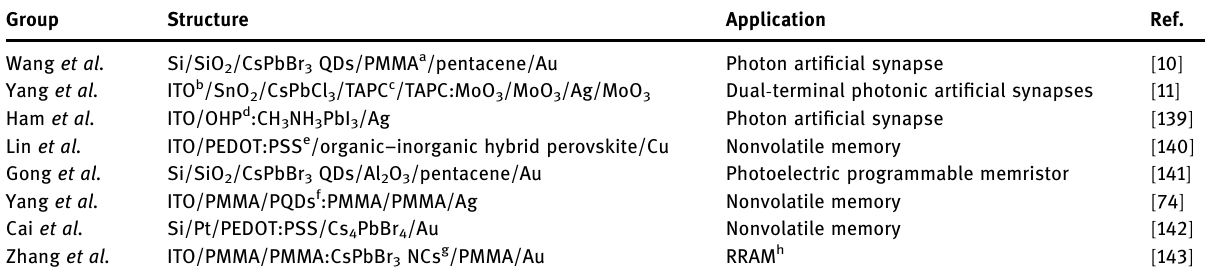
Table 2: Overview of optical memristive devices based on perovskites Group